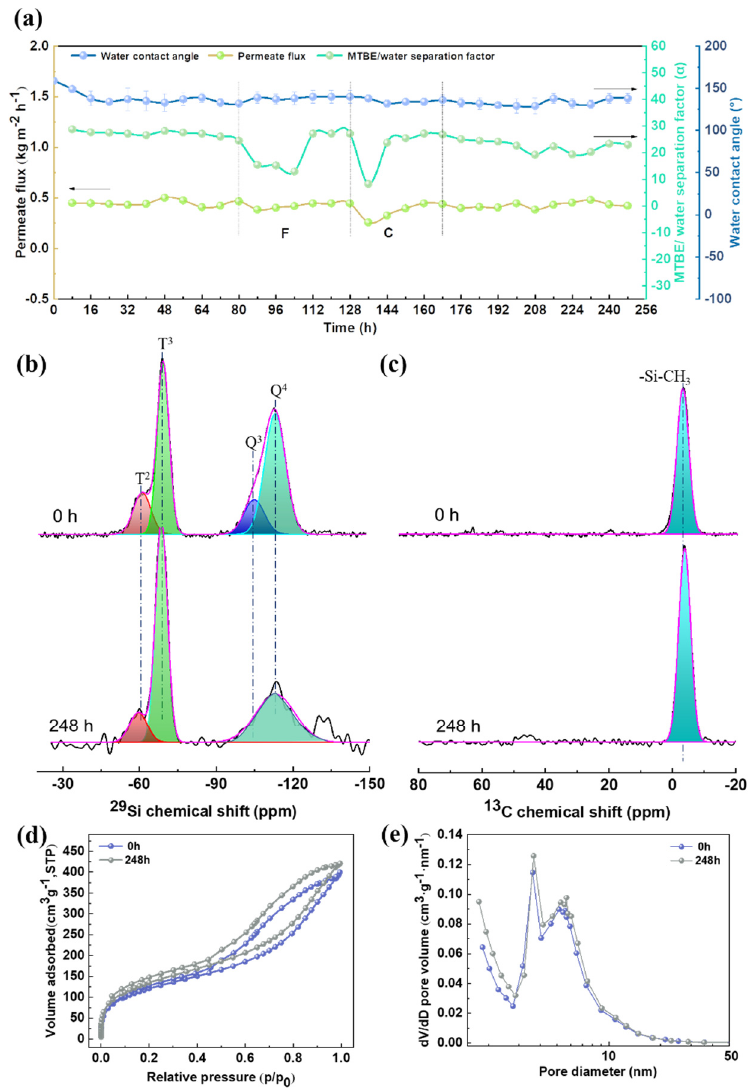
Figure 7. Long ‐ term stability of the MSL ‐ 10 membrane operating under the operating conditions as follows: a feed temperature of 30 °C, an MTBE concentration of 4.6 wt%, and a feed flow rate of 200 mL min − 1 , except for the F and C regions, where region F indicates that the measurement is conducted by varying the feed flow rate and region C represents the variation of the MTBE content in feed solution ( a ). Solid state 29 Si MAS ( b ) and 13 C MAS ( c ) NMR spectra, N 2 adsorption ‐ desorption isotherms ( d ), and pore size distribution ( e ) of the unsupported MSL after exposure to the MTBE aqueous solution for different times.